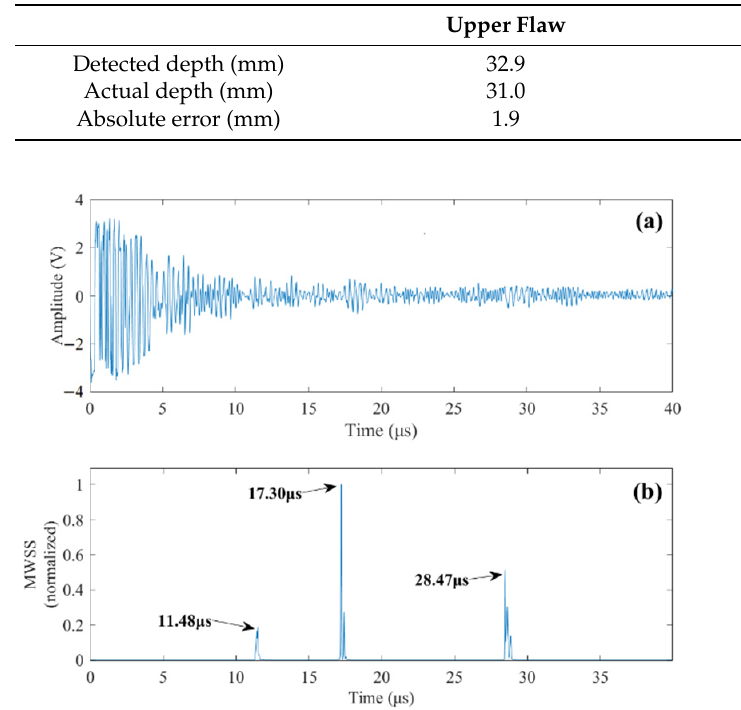
Figure 9. ( a ) A-scan signal of both upper and lower flaws. ( b ) Obtained MWSS values revealing the time delays of the two flaw echoes and bottom reflection. Using the time-of-flight principle, the depths of the flaws are obtained and compared with their actual values. The results are tabulated in Table 3, showing satisfactory accuracy of the proposed